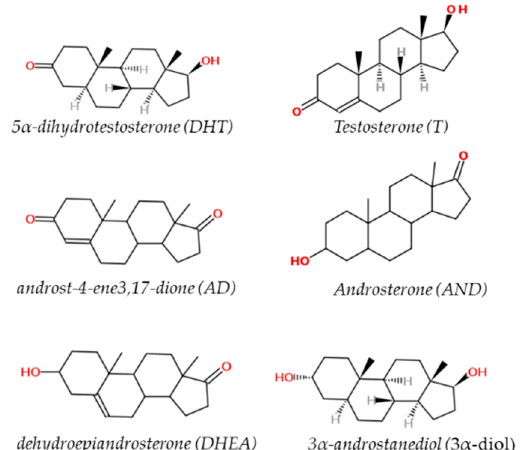
Figure 1. Chemical structure of testosterone (T), 5 α -dihydrotestosterone (DHT), androst-4-ene3,17- dione (AD), androsterone (AND), dehydroepiandrosterone (DHEA) and 3 α -androstanediol (3 α - diol).